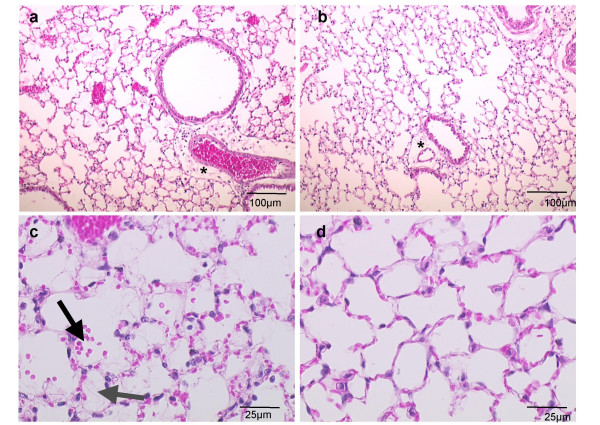
Histology following hyperoxic injury. Hematoxylin-eosin stained lung sections of (a) IGF-1R+/+, and (b) IGF-1Rneo/- mice following 72 h of hyperoxic exposure, illustrating perivascular and peribronchiolar edema as indicated by asterisks. Magnification: 10× objective. Representative histology of lung sections demonstrates (c) focal alveolar hemorrhages (black arrow) and hyaline membrane formation (gray arrow) in IGF-1R+/+ lungs, and (d) minimal lesions in IGF-1Rneo/- mice. Magnification: 40× objective.